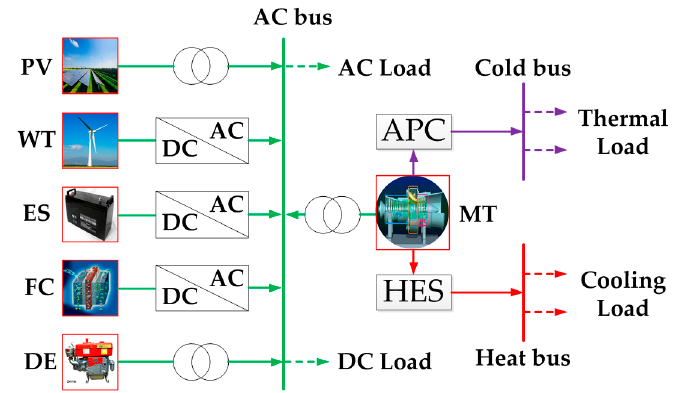
Figure 6. The structure of stand-alone MG; photovoltaic (PV), wind turbine (WT), MT and energy storage (ES), fuel cell (FC), diesel engine (DE). Table 1. Parameters of different distributed generations (DGs); MT: micro-gas turbine.